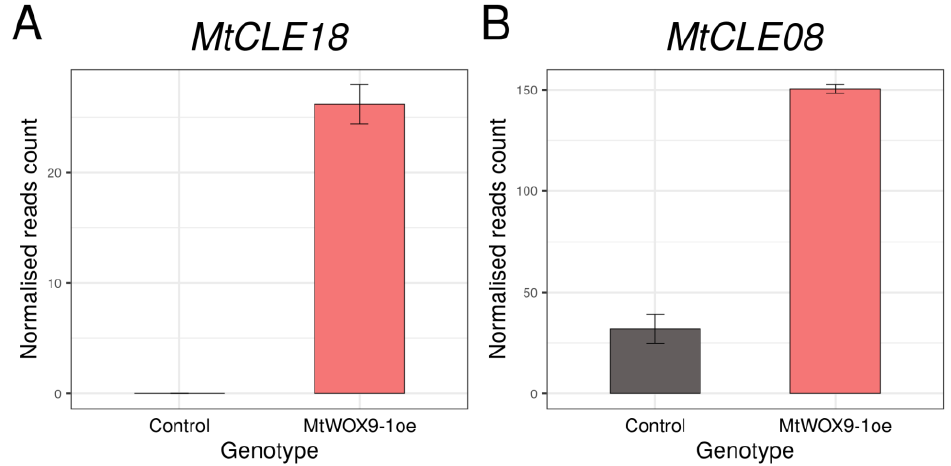
Figure 1. Expression levels of MtCLE18 ( A ) and MtCLE08 ( B ) in control (R108) calli and calli with MtWOX9-1 overexpression according to the transcriptomic analysis [17]. Error bars represent the standard error for two biological replicates.